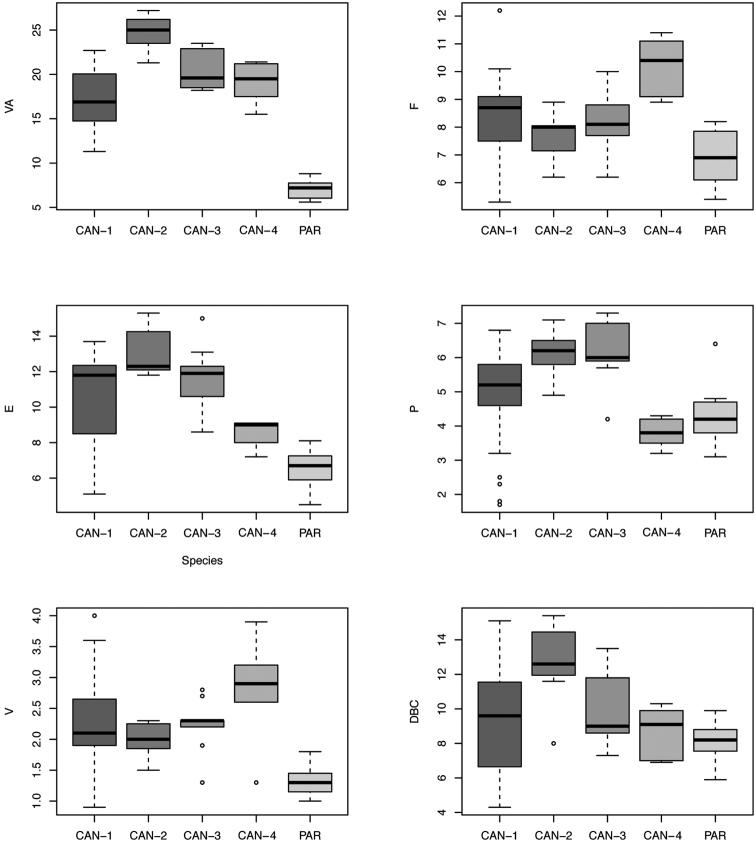
Box plots for anatomical characters of the five Monacha clades investigated. The lower and upper limits of the rectangular boxes indicate the 25th to 75th percentile range, and the horizontal line within the boxes is the median (50th percentile).